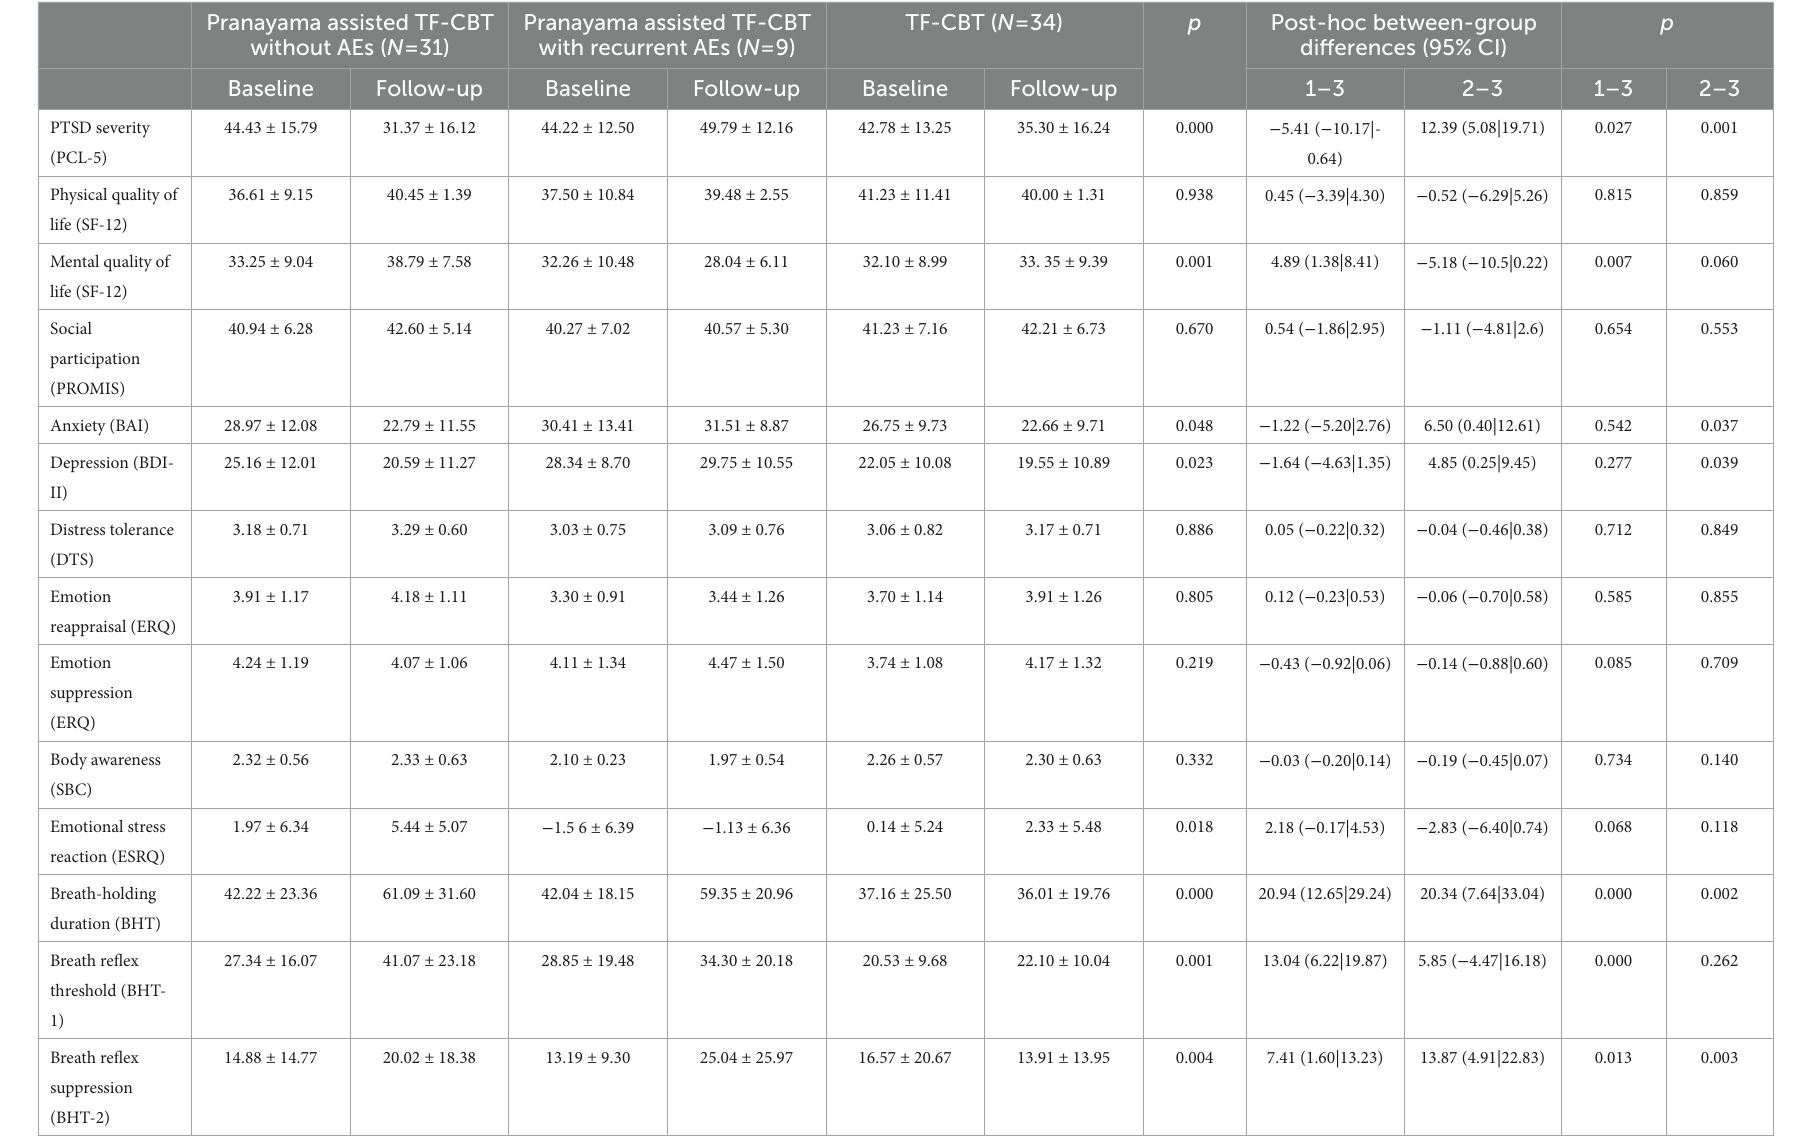
TABLE 5 Results (means and standard deviations) of the per-protocol